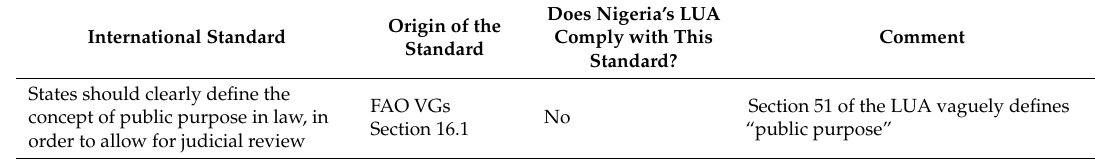
Table 2. Summary of the Legal